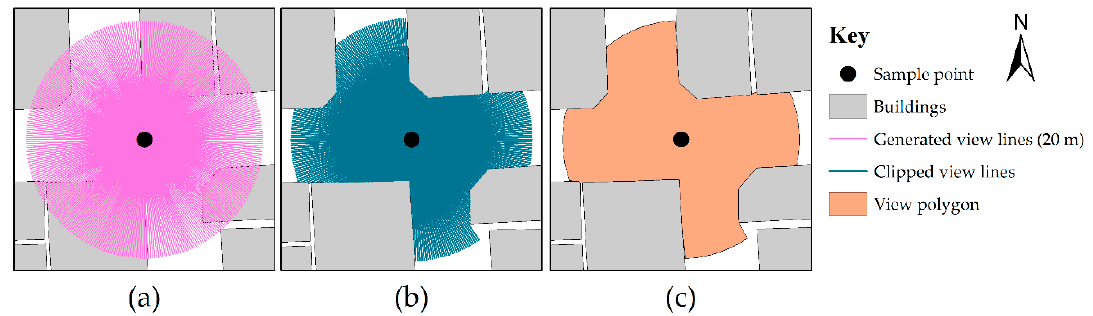
Figure 3. The generation of view lines and view polygons. ( a ) 360 view lines generated, each 20 meter in length, at 1° interval. ( b ) View lines clipped by building footprints. ( c ) View polygon generated from the minimum bounding convex hull of the clipped view lines.